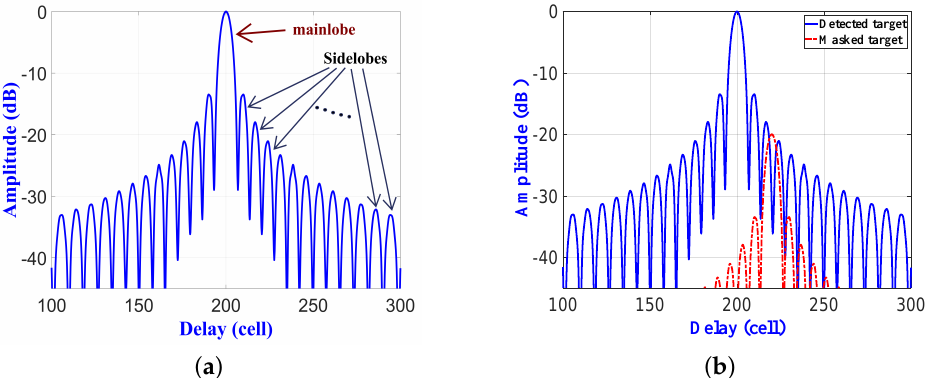
Figure 1. ( a ) Mainlobe and sidelobes of Matched Filter (MF) for a stationary target. ( b ) Masked target within the sidelobes of a detected